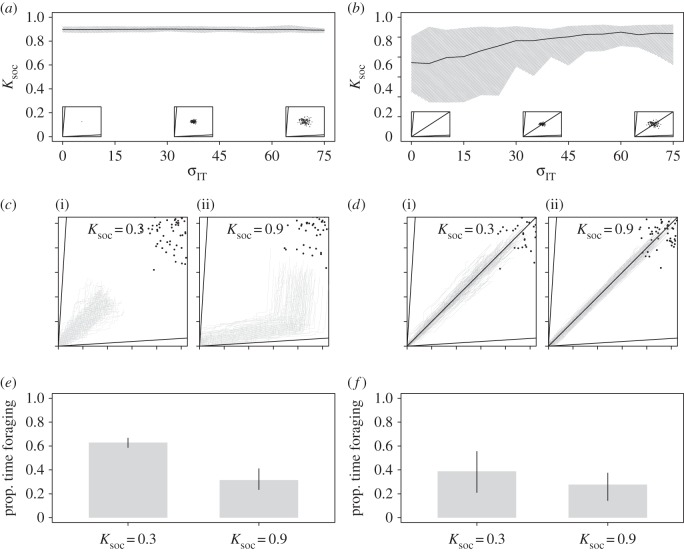
Unimodal variance in individual nutrient requirements and the evolution of collective foraging. Mean and 0.025–0.975 quantile of Ksoc after 1000 generations at differing levels of σIT and T = 4 based on 30 model runs in (a) a two-food and (b) a three-food environment. Embedded in each panel is a geometric depiction of the nutritional environment showing the modelled food rails (V), and a visualization of variation in individual ITs at certain values (σIT of 0, 37.5 and 75 are shown). Traces of the movement of 100 agents through the nutrient space (grey lines) and their intake targets (black points), where T = 4, σIT = 75 and Ksoc = 0.3 (i) and Ksoc = 0.9 (ii) in (c) a two-food environment and (d) a three-food environment. The mean (±0.025–0.975 quantile) proportion of that model run spent foraging (i.e. moving between foods), by those individuals in (e) a two-food environment and (f) a three-food environment (see table 1 for all parameters and variables).